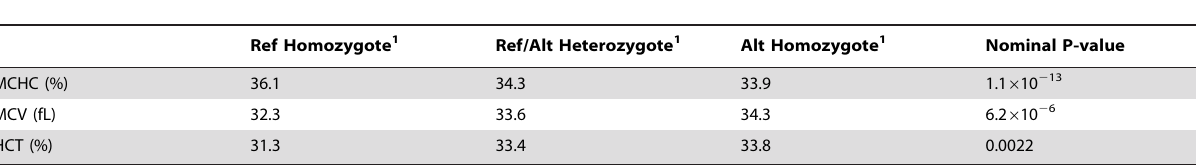
Table 3. Significant Phenotypic Values for Divergent Artiodactyl MYADM- like Repeat by